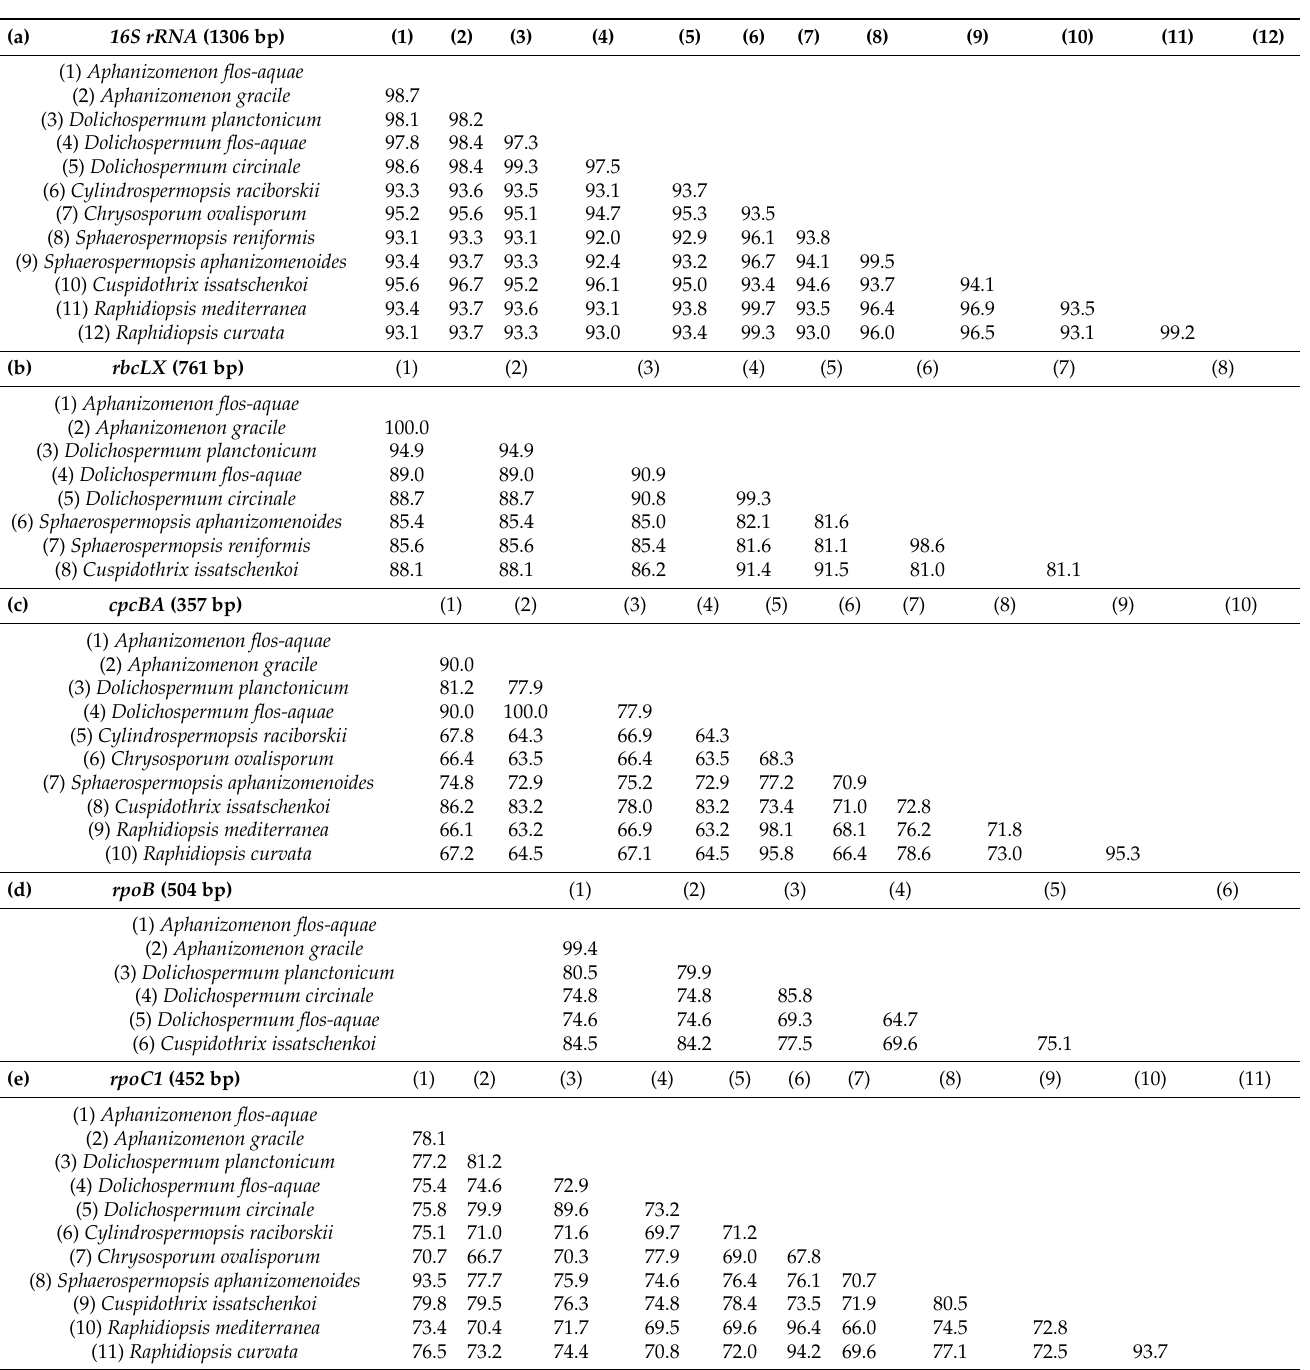
Table 2. Sequencesimilarities(%)oftargetgenes(a; 16SrRNA ,b; rbcLX ,c; cpcBA ,d; rpoB ,e; rpoC )amongnostocaleancyanobacteria. (a) 16S rRNA (1306